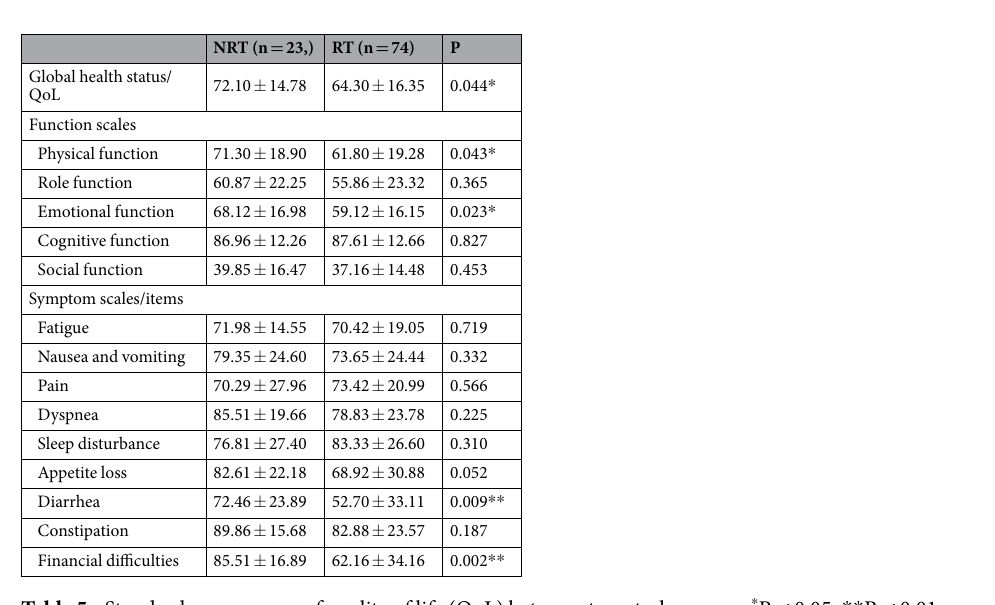
Table 5. Standard mean scores of quality of life (QoL) between two study groups. * P < 0.05. ** P <